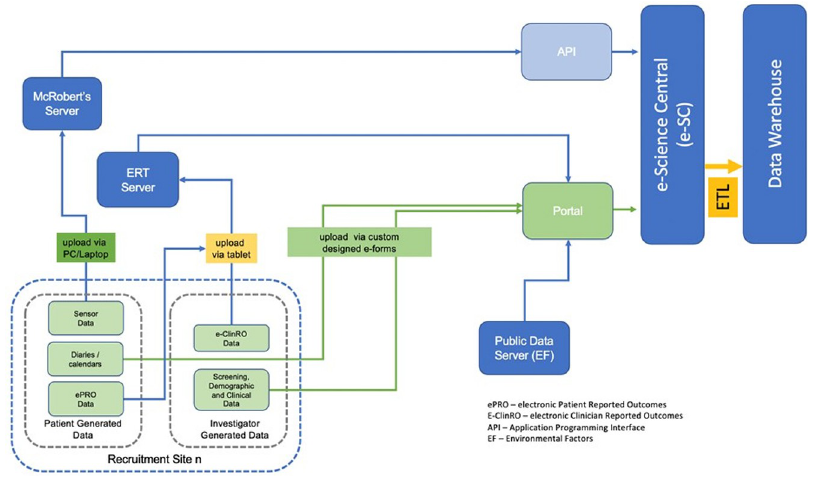
Fig 4. Proposed data